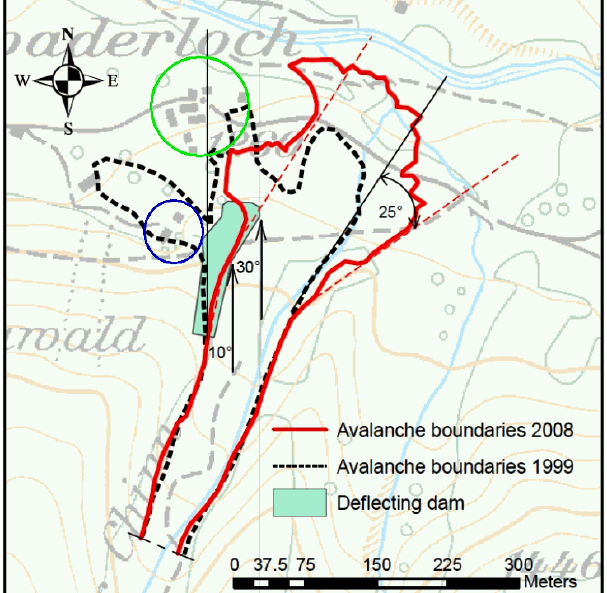
Fig. 2. Outlines of the 1999 avalanche (black dashes) and the 2008 avalanche (red line). The buildings in the blue circle were severely damaged in 1999, but those in the green circle (Brosi area) were not. Arrows indicate the main flow direction of the 1999 avalanche. The red dotted line on the left shows the local direction of the dam axis. Note that it also coincides with the 2008 avalanche main flow di- rection. The red dotted line on the right shows the maximum lateral spreading of the 2008 avalanche.